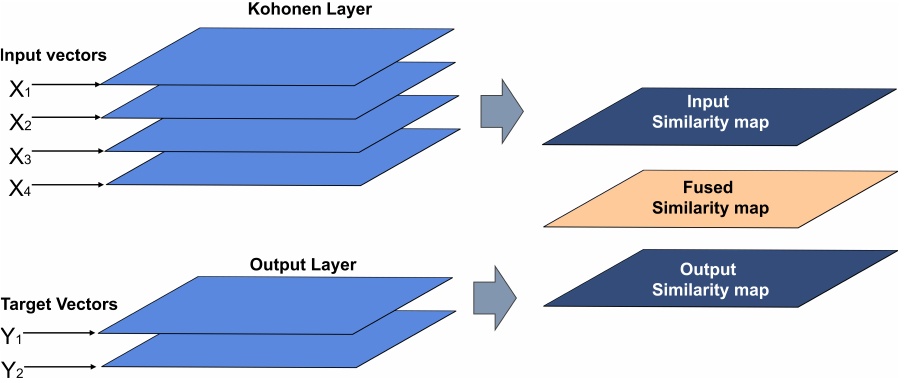
Figure 8. X–Y fused Kohonen network